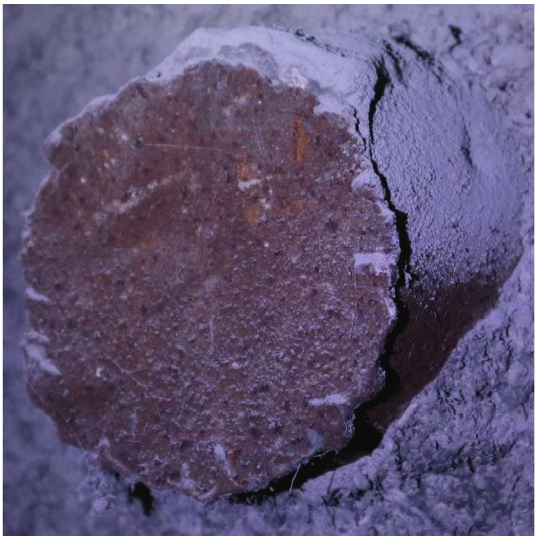
Figure 4: Protective cap on the anchorage top of the anchor